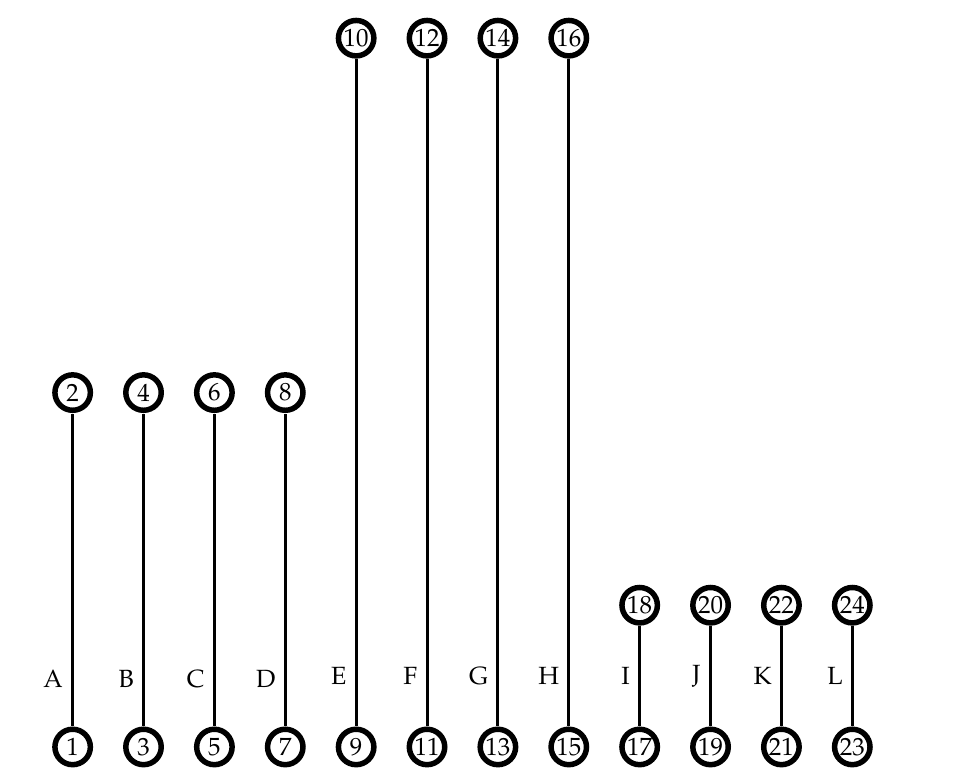
Figure 3. Example of instance used to illustrate the initialization of the MOVNS. The coverage rows assignment procedure is described in Algorithm 2 using the instance problem shown in Figure 3 as an example of input. Initially, the total coverage length, calculated as the sum of all row lengths, is divided among the vehicles considering their performance (lines 1–7). A portion of the total coverage length is defined for each UAV, r x , limiting the assignment of rows with regards to their lengths. The variable r x is i i not bounded by the vehicle’s real flight capacity, F x : this variable is only an estimate used to balance the coverage row distribution, considering the row length and the relative vehicle performance. The r x of each UAV is based on the recharging-flight time ratio q ( m ( x i )) , i assigning more coverage area to the vehicle with the lowest q-value (i.e., its coverage area must be greater than that of other vehicles with a higher q-value). For this, the vehicle’s performance is evaluated based on the q-value of the best model (line 3). Then, the amount of coverage for each UAV is estimated by splitting the total coverage length according to ÷ p the ratio between the vehicle performance and the overall performance p x all (line 7). i In the example, the sum of all row lengths in L all (total_length) is 70 km, q min = 1, resulting = 0.67 × 70 = 46.9 km and r = 0.33 × 70 = 23.1 km. in r x x 2 1 After, the rows are sorted from the longest to the shortest (line 8), resulting in the sequence (cid:104) E , F , G , H , A , B , C , D , I , J , K , L (cid:105) . The estimated coverage length assigned to the vehicle is used to sort the clusters in descending order (line 9). In the example, this step keeps the order as X = (cid:104) x 1 , x 2 (cid:105) . Next, each UAV row set is assigned a row considering the row length order and the vehicle performance (line 11). In the example, the first rows assigned are L ( x 1 ) = { E } and L ( x 2 ) = { F } . After, r x is updated (line 12), making i